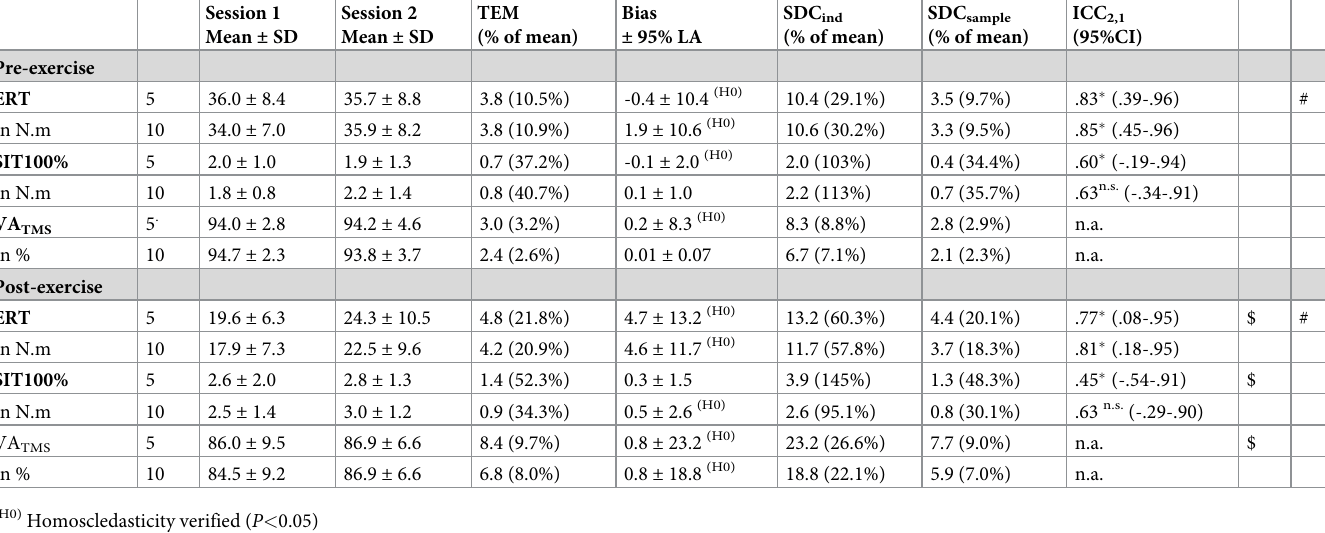
Table 4. Between-session Mean ± SD and reliability data for the determination of VA TMS using the first 5 (n = 8) and all 10 contractions for the estimation of ERT (n =